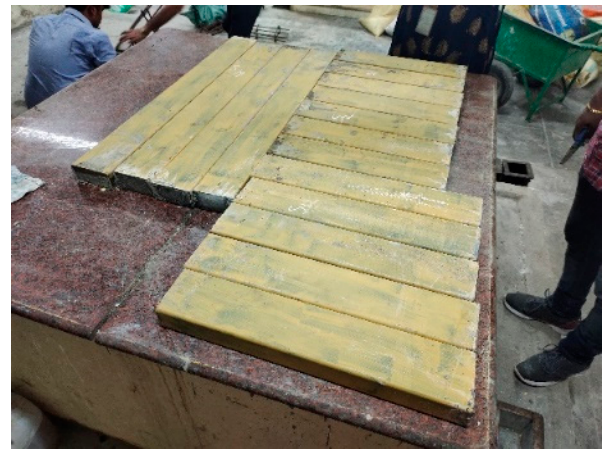
Figure 2. Rectangular steel tubular sections.